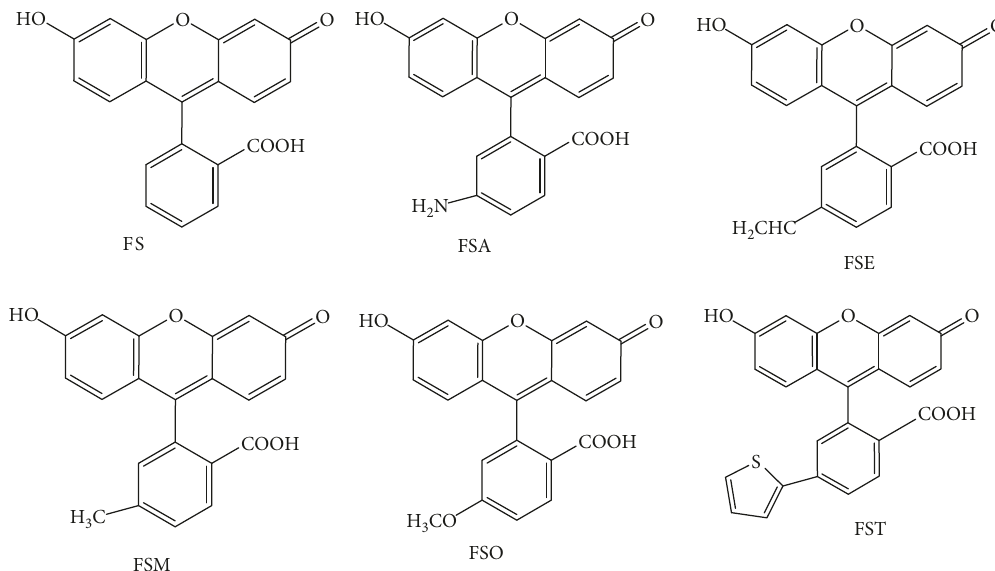
Figure 1: Chemical structures of fl uorescein and its